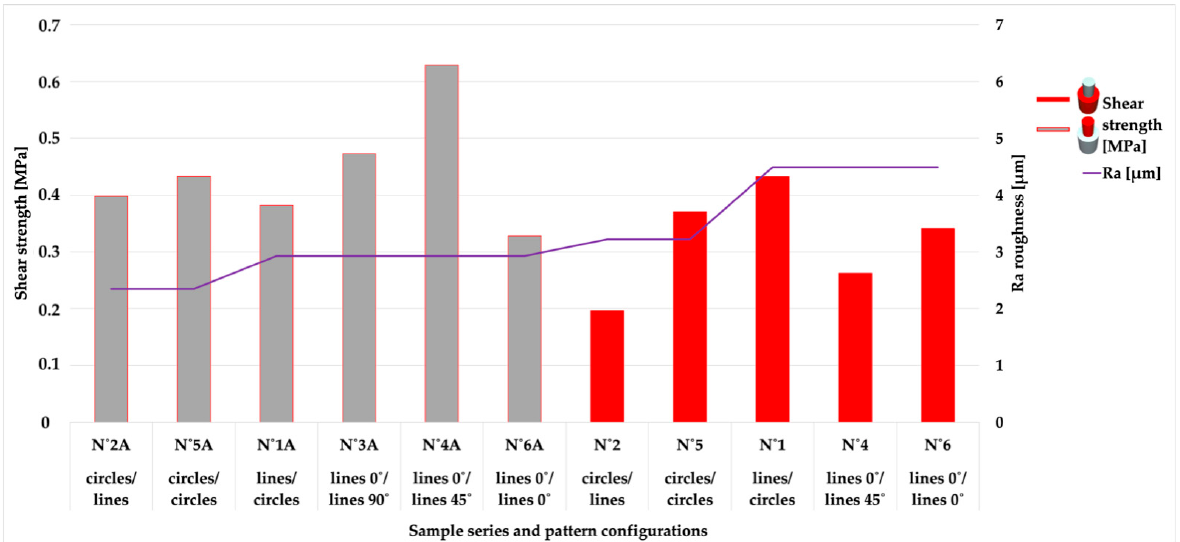
Figure 12. The relationship between roughness (Ra) and shear strength for each pattern and material combinations.